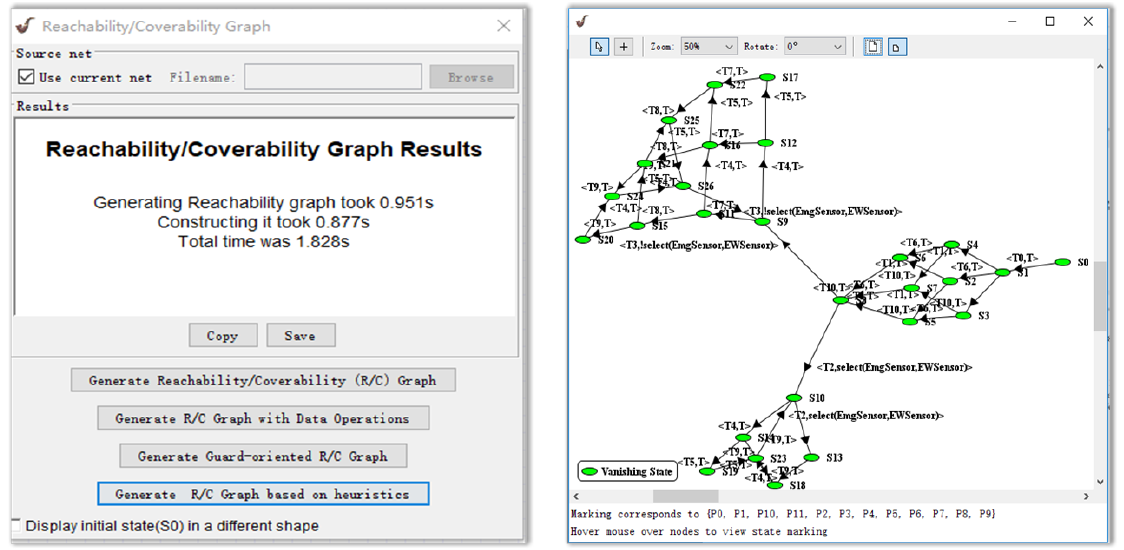
Figure 10. A guard-driven reachability graph (GRG) of Figure 9. ( a ) A user interface for generating a GRG; ( b ) the visualization of a